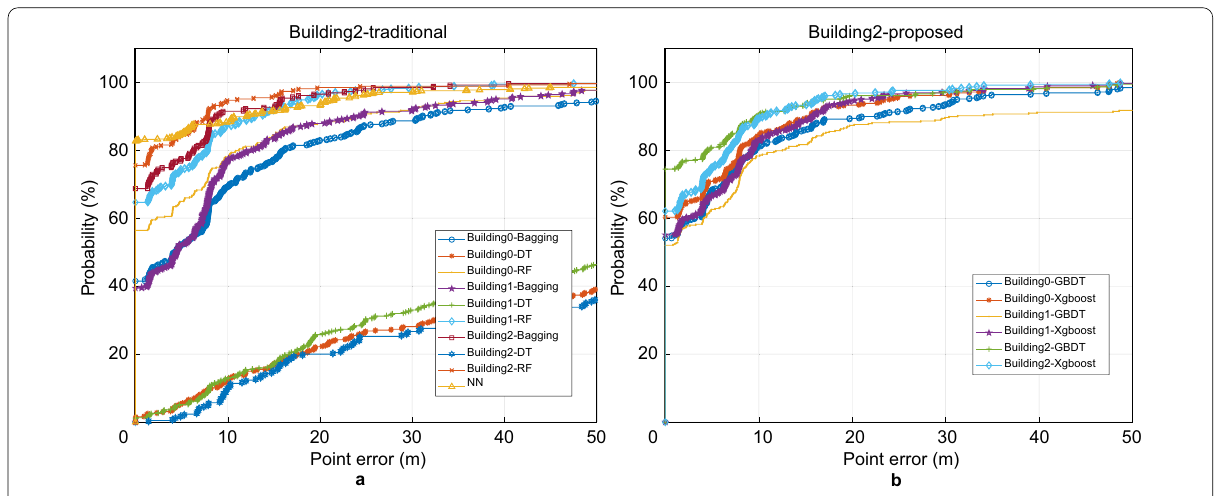
Fig. 9 The CDFs of Building2 using traditional methods and the proposed